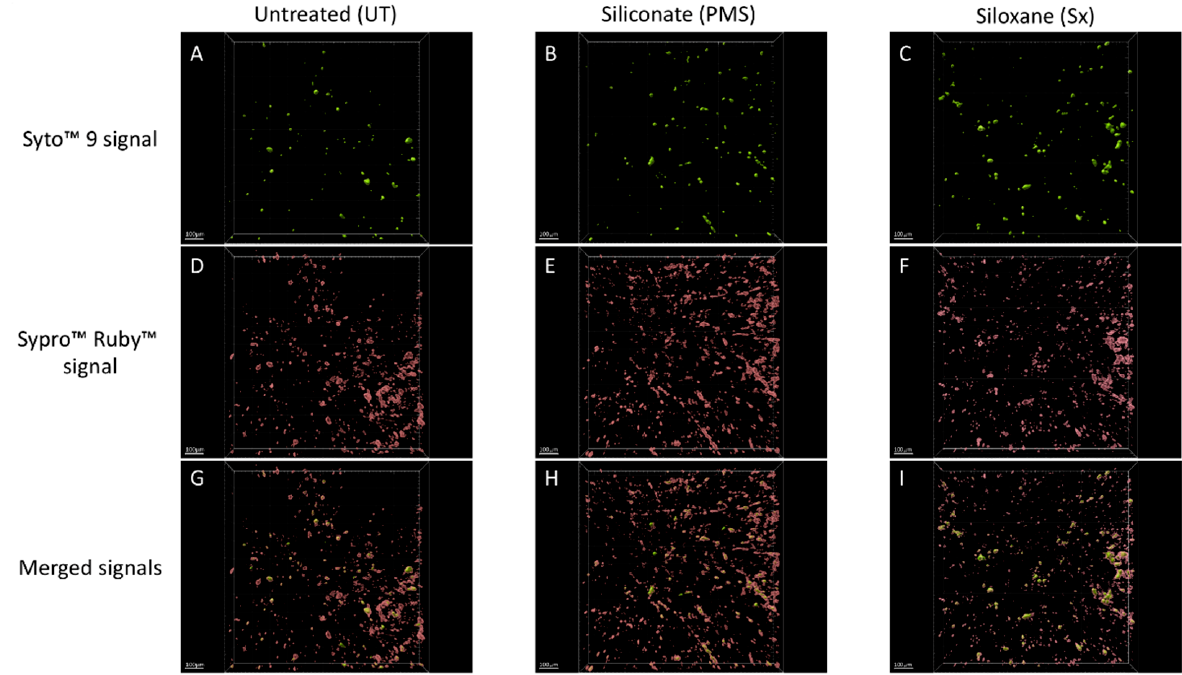
Figure 2. Fluorescent macroscopic images of the biofilm colonizing tiles exposed 6 years (100 µ m scale): ( A – C ) Syto 9 signal: ( A ) UT tile, ( B ) PMS tile, and ( C ) Sx tile. ( D – F ) Sypro Ruby signal: ( D ) UT tile, ( E ) PMS tile, and ( F ) Sx tile. ( G – I ) Syto 9 and Sypro Ruby merged signals: ( G ) UT tile, ( H ) PMS tile, and ( I ) Sx tile.